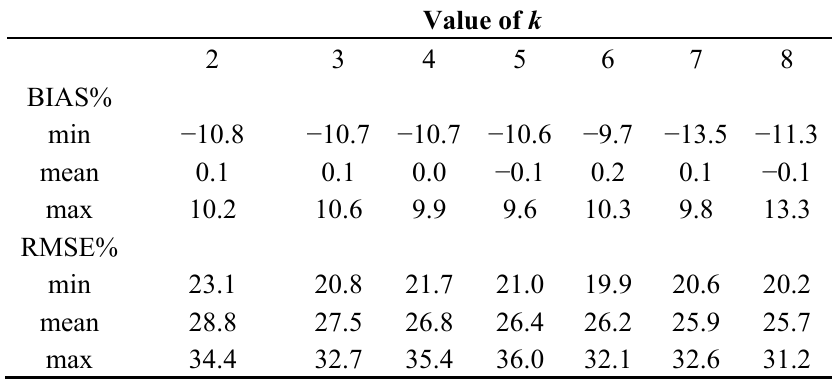
Figure A1. The effect of k -value to the estimated bias% ( right ) and RMSE% ( left ) of totalB using point metrics as predictor variables. Table A2. The effect of k -value to the estimated bias% and RMSE% of totalB using CHM metrics as predictor